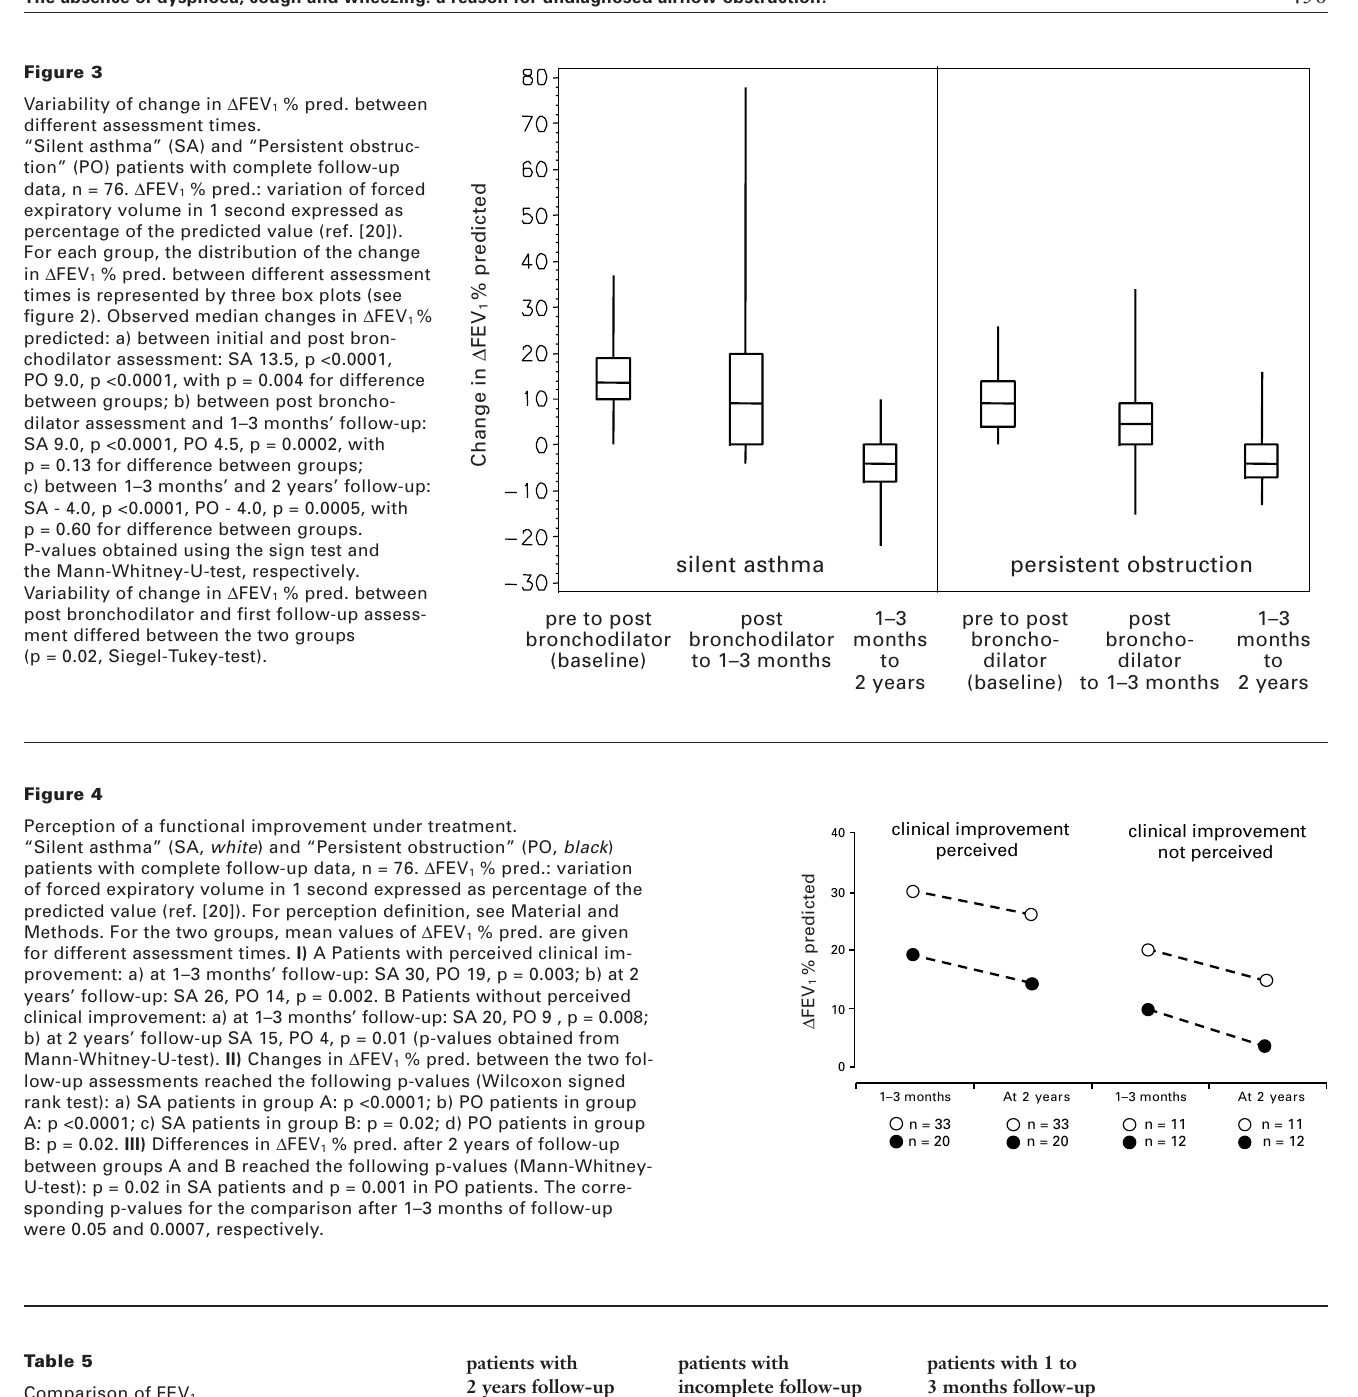
Comparison of FEV 1 % predicted between subjects with and without complete